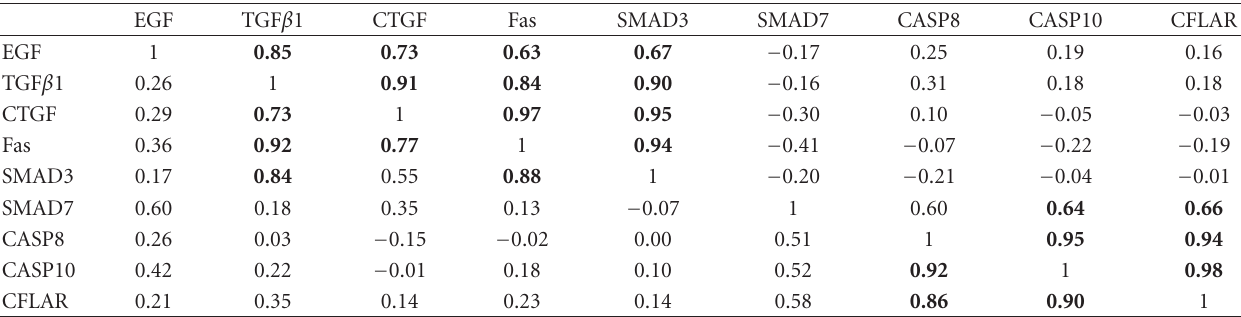
Table 2: Coexpression matrices for nine Fas-related genes assayed by RT-PCR in 23 complete medium control (top panel) and 18 serum- free (SF) control (bottom panel) SW1353 chondrosarcoma cell cultures. Correlation coe ffi cients in bold are significant at P ≤ 1 . 1 E − 03 (Bonferroni’s adjustment).